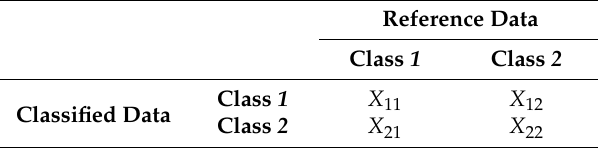
Table 5. Cross-tabulation of the counts of correctly classified and misclassified